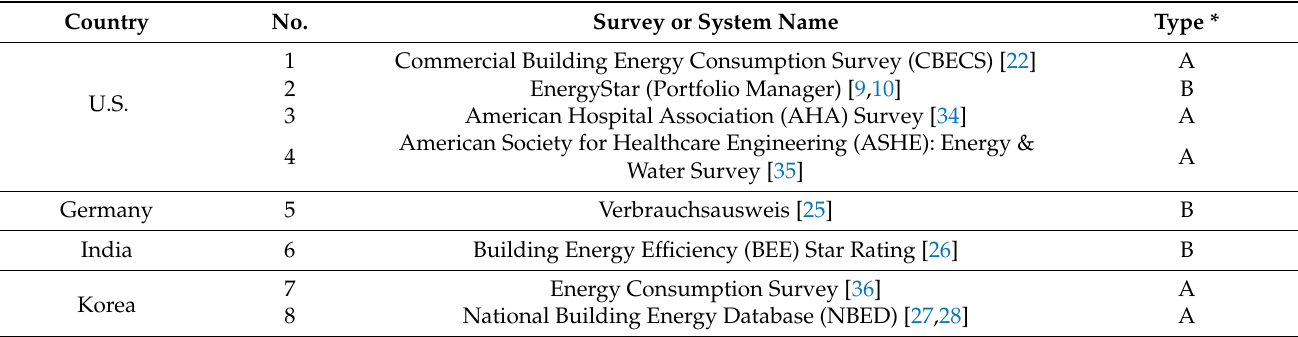
Table 1. Energy use-related surveys or systems for hospitals by